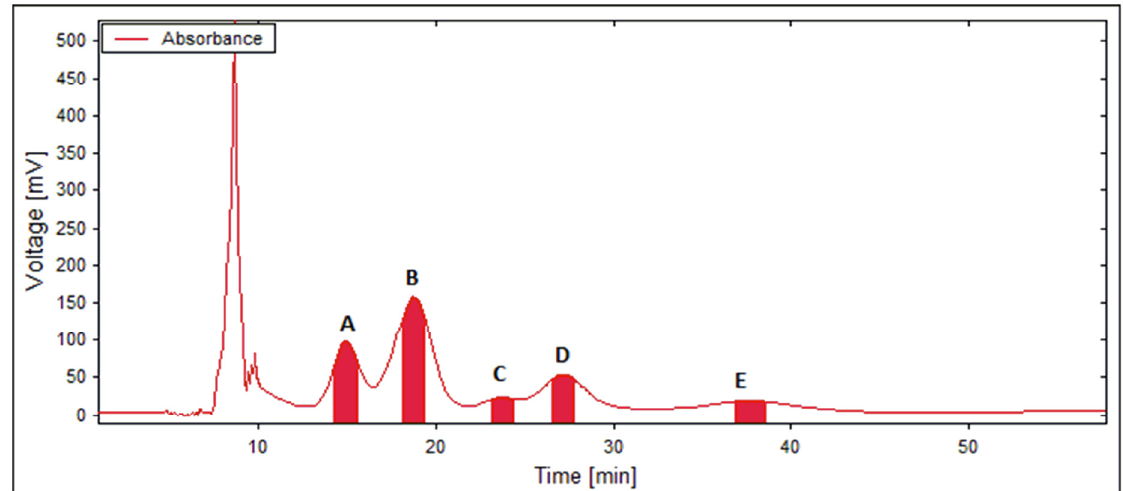
Figure 2. On ‐ line chromatogram of the LLC separation of the target constituents from Ferula penninervis methanolic root extract. Biphasic solvent system: n ‐ hexane/ethyl acetate/methanol/water (3/2/3/2, v/v/v/v ); Elution mode: reversed ‐ phase (head ‐ to ‐ tail), Unit: CCC; Column volume: 136 mL; Flow ‐ rate: 6 mL/min; Rotation speed: 1600 rpm; Injection volume: 6 mL; Extract concentration: 40 mg/mL; UV: 254 nm. The collected fractions were labelled with letters ( A – E).